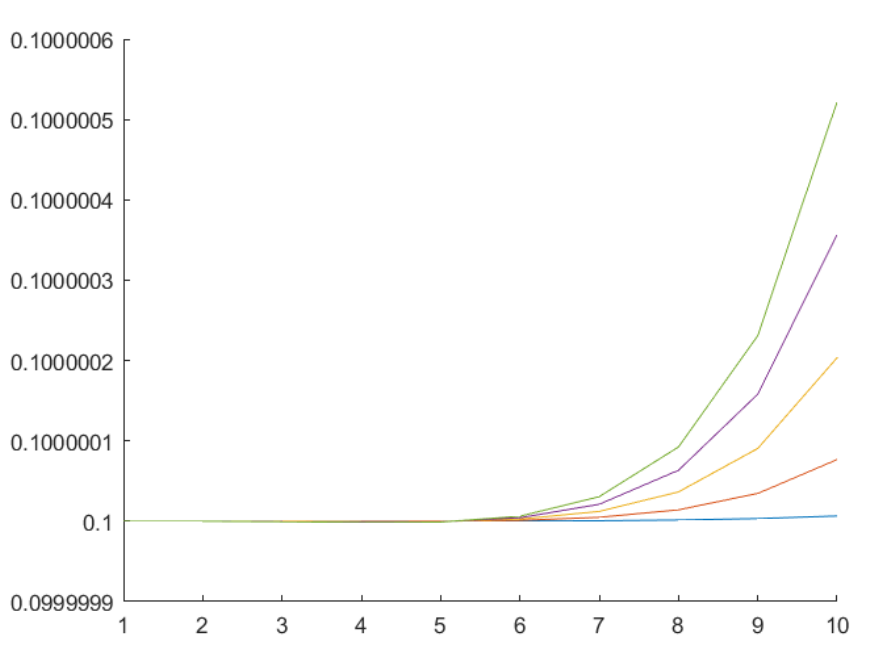
Figure 7. “Feather” angles β change under the control